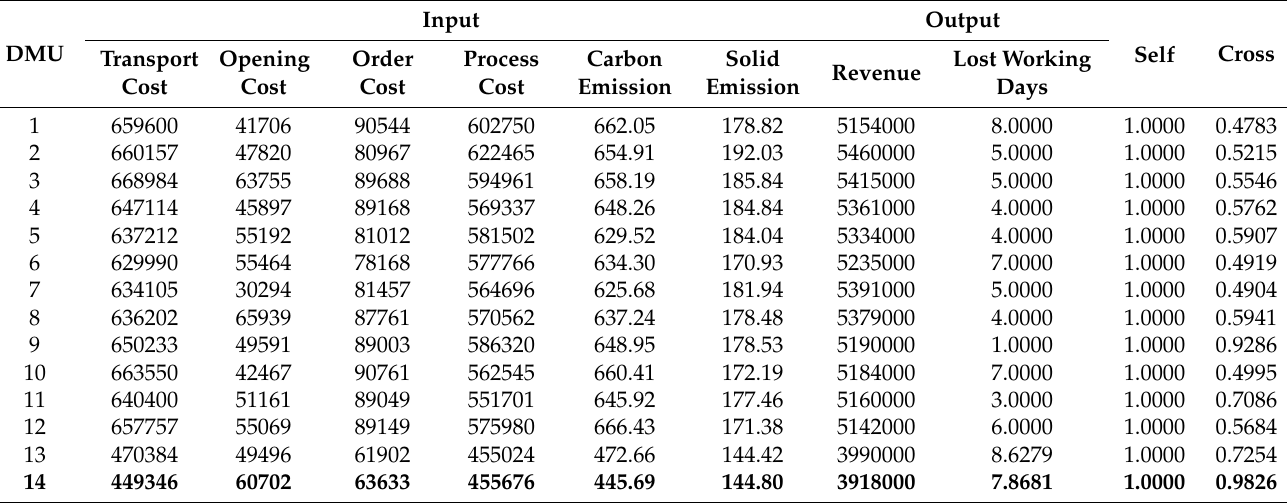
Table 5. Indicators and efficiency values calculated by SG-MOPSO.